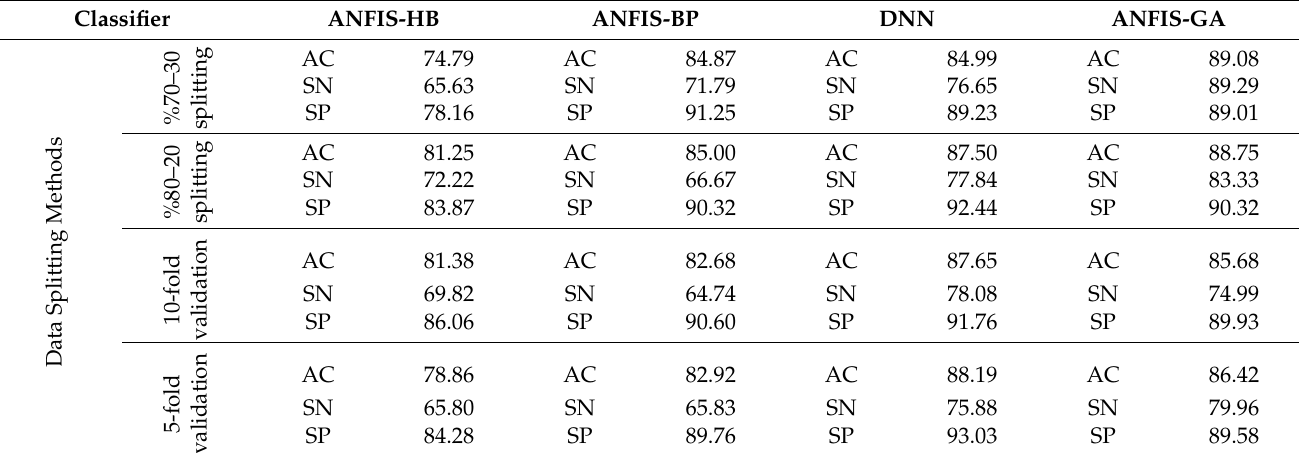
Table 2. The performance of the proposed method compared to conventional methods for 27